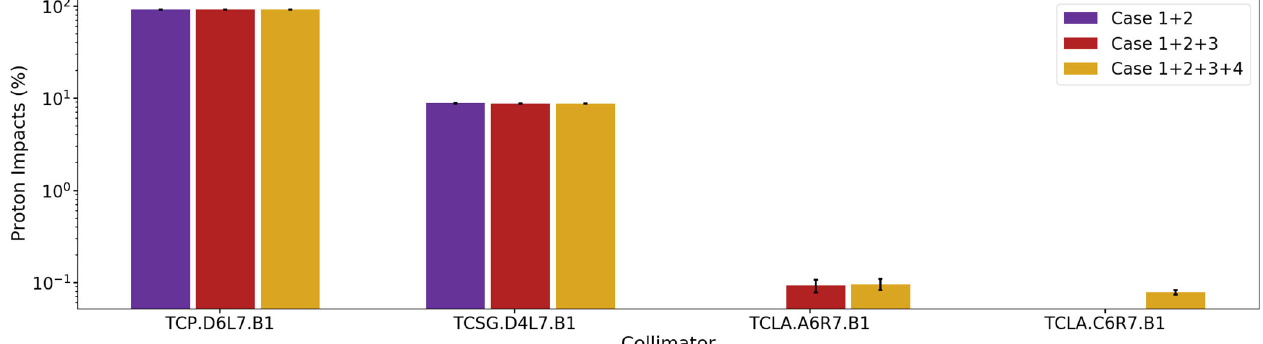
FIG. 13. The percentage distribution of the predicted proton impacts for the three configurations of closed collimators in the vertical